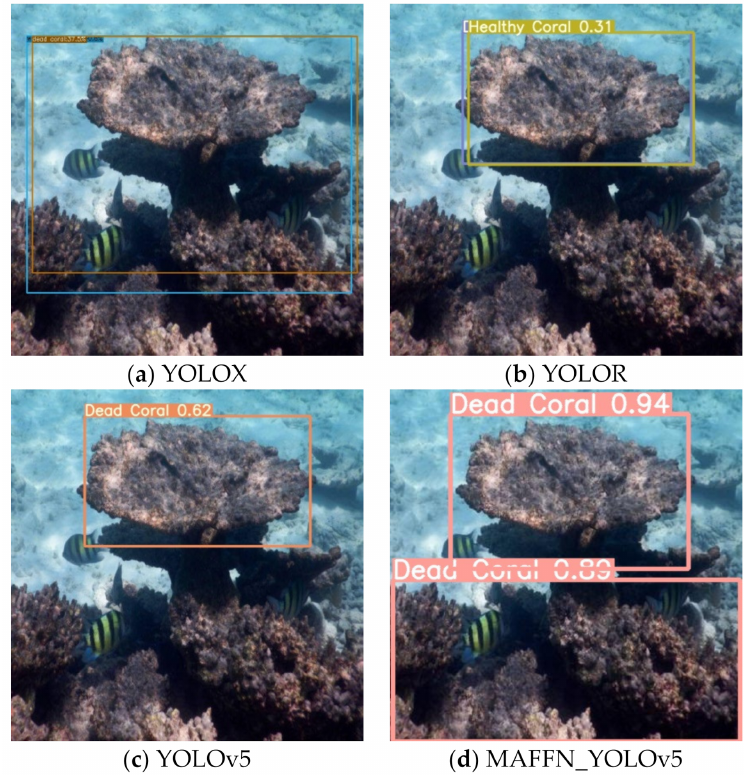
Figure 27. Dead coral